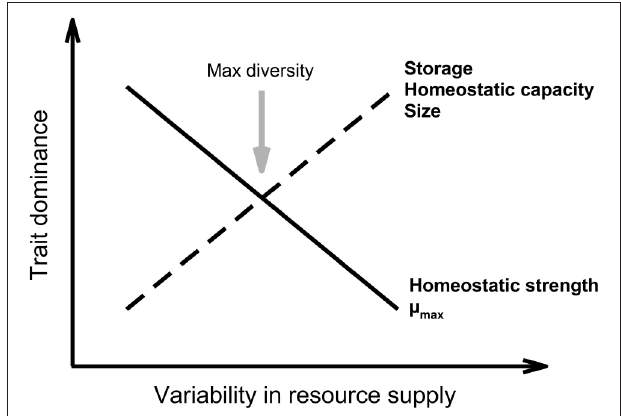
FIGURE 3 | Influence of variability in resource supply on traits. Increasing variability is expected to influence the trade-off between fast growth and investment in storage. Higher variability should therefore yield communities with larger organisms with greater storage and homeostatic capacities, but slower maximal growth rates. Moreover, the intermediate disturbance hypothesis suggests that local species diversity should be maximized when ecological disturbance is neither too rare nor too frequent ( Wilkinson, 1999). Biodiversity should therefore be maximal at intermediate resource supply variability (gray